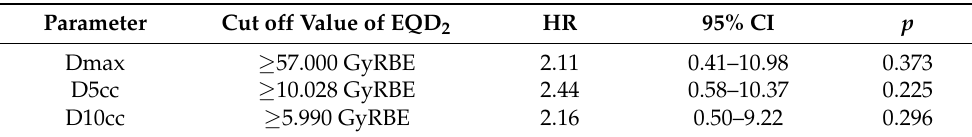
Table 5. Relationship between dosimetric parameters and Grade 2 or higher gastroduodenal toxicities in stereotactic body proton beam therapy ( n =